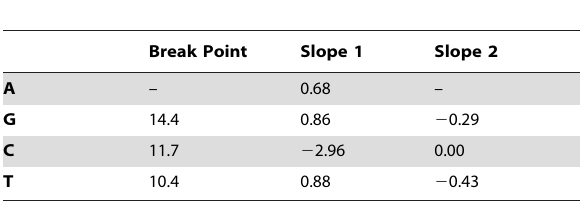
Table 1. Break points and slopes of the ensemble graphs for Arabidopsis thaliana